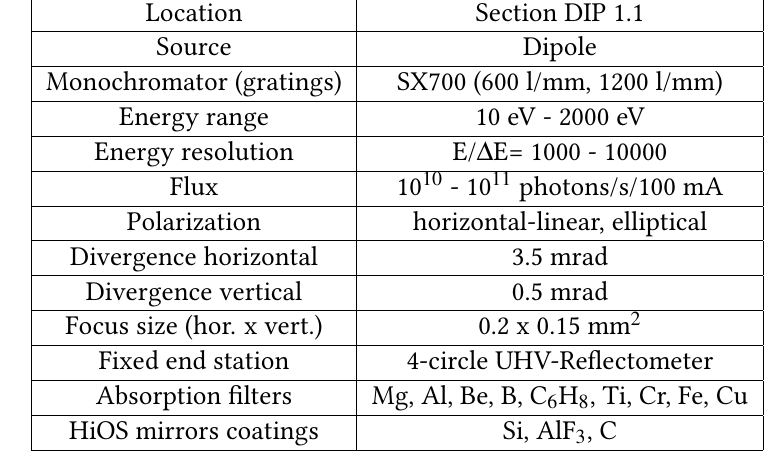
Section DIP 1.1